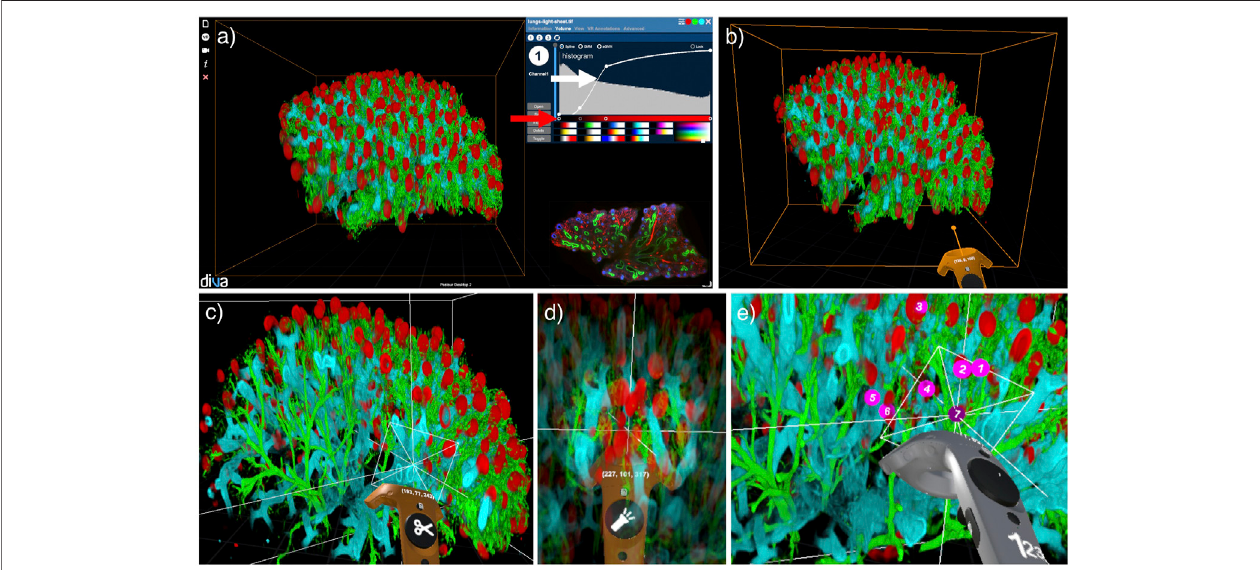
FIGURE 1 | The DIVA dual interface presented on an example of a light-sheet microscopy image of a human fetus lung with pulmonary alveoli (in red), trachea (in blue)andvascularsystem(ingreen)(Belleetal.,2017). (A) Desktopinterfacewithrawdatainthebottomrightcornerandtransferfunctioninterfaceinthetoprightcorner withcurvesforvoxelopacity(whitearrow)andcolor(redarrow). (B) VRinterfacewithVRcontrollerinorange. (C) ClippingtoolwiththeVRcontrollertonavigateinsidethe volume. (D) Flashlight tool with the VR controller to highlight a spherical area of interest. (E) Counter tool with the VR controller to enumerate elements of interest.